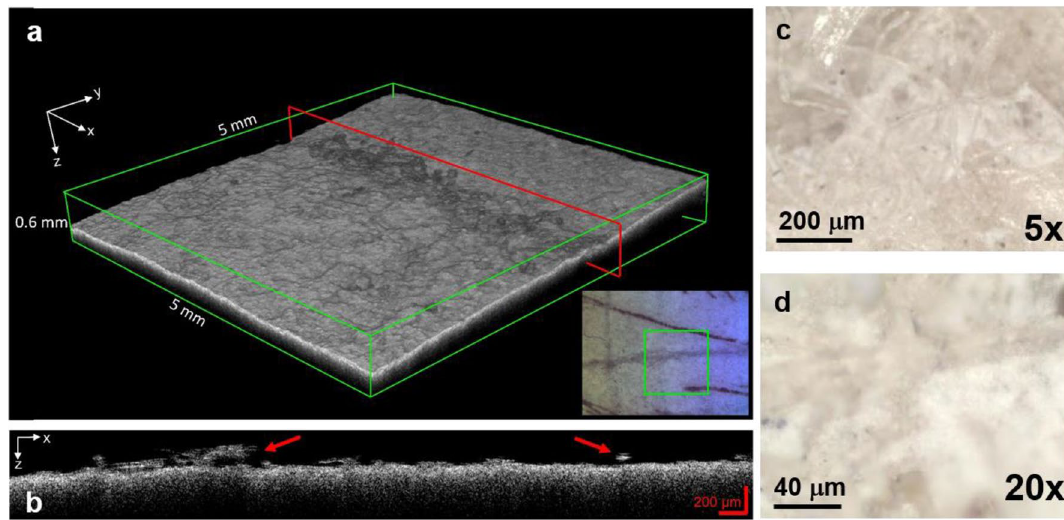
Figure 7. Area of the watermark where the white barium sulphate particles were identified: ( a ) OCT 3D image cube of the groove of the watermark, the red line highlights the y position of the x–z section reported in ( b ), the red arrows indicate the white particle agglomerates. Microphotographs of the particles trapped within the paper fibres in the watermark at ( c ) 5× and ( d )